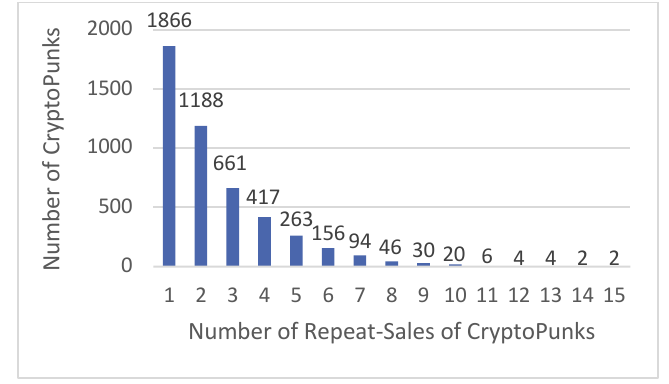
Figure 3: Repeat-Sales of CryptoPunks